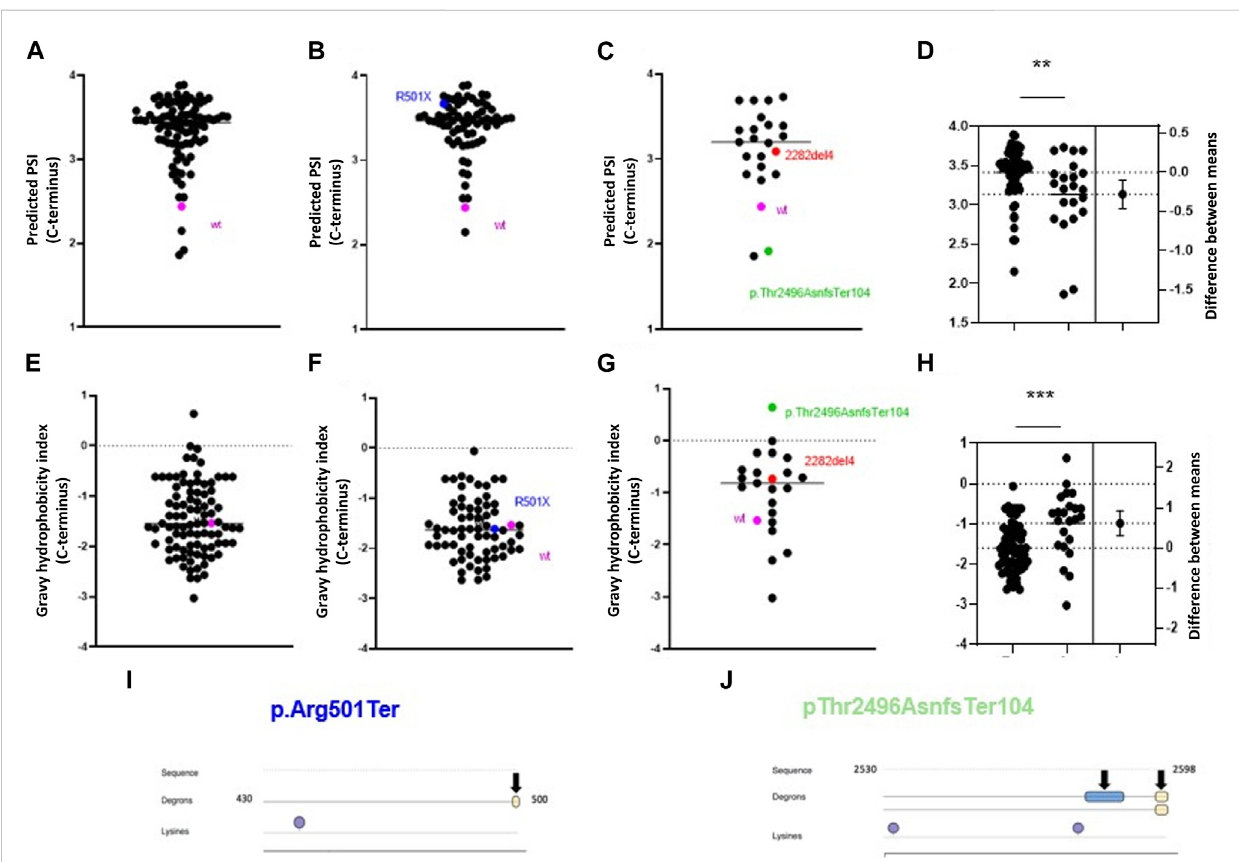
FIGURE 6 Alterations in pro fi laggrin stability in FLG null mutation carriers. (A – D) C-terminal PSI of recurrent pathogenic frameshift (C) , nonsense mutation (B) and combined (A) here wild type is shown as pink and two most common European mutations 2282del4 and R500X are marked in red and blue; (D) estimationplot and comparison betweenPSI scores; Student ’ st-test; p < 0.01 (**); (E – H) C terminal Gravyhydrophobicity index ofrecurrentpathogenic frameshift (G) , nonsense mutation (F) and combined (E) here wild type is shown as pink and two most renowned mutation 2282del4 and R500X are marked in red and blue; (H) estimation plot and comparison between PSI scores; Student ’ s t-test; p < 0.001 (***); (I) Location of C-terminal degron in p.Arg501Ter and Lysine residue. (J) Location of C terminal degrons and lysine residues in the